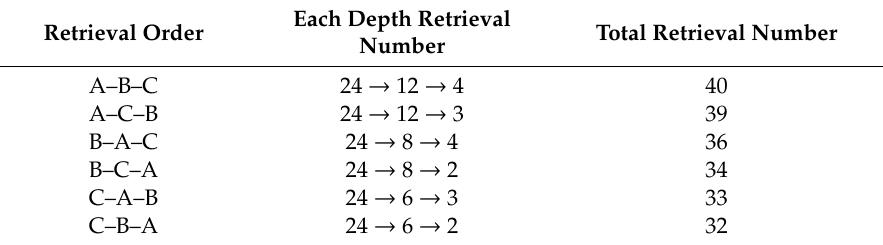
Table 3. Policy decision tree retrieval